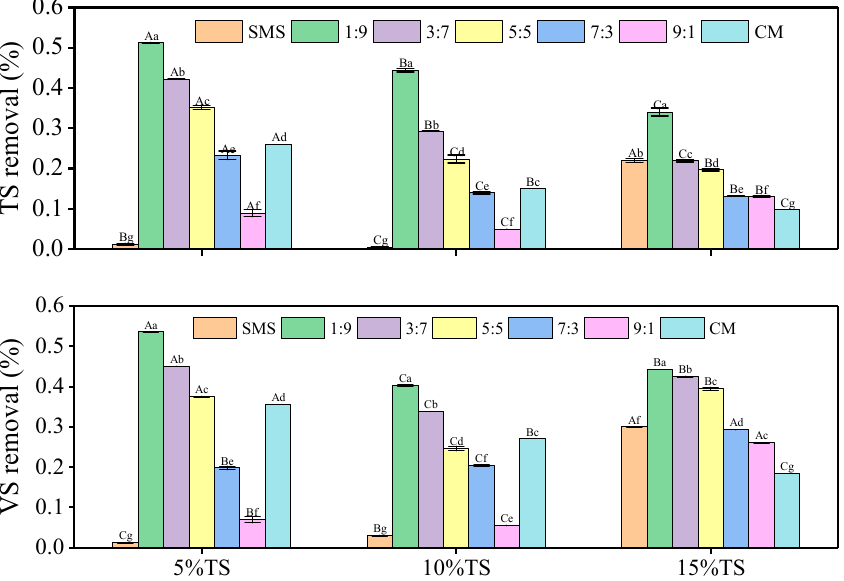
Figure 5. TS and VS removal efficiencies under different feedstock ratios and solids content. Here, A, B, and C represent the significance between TS content; a, b, c, d, e, and f represent the significance between feedstock ratios.